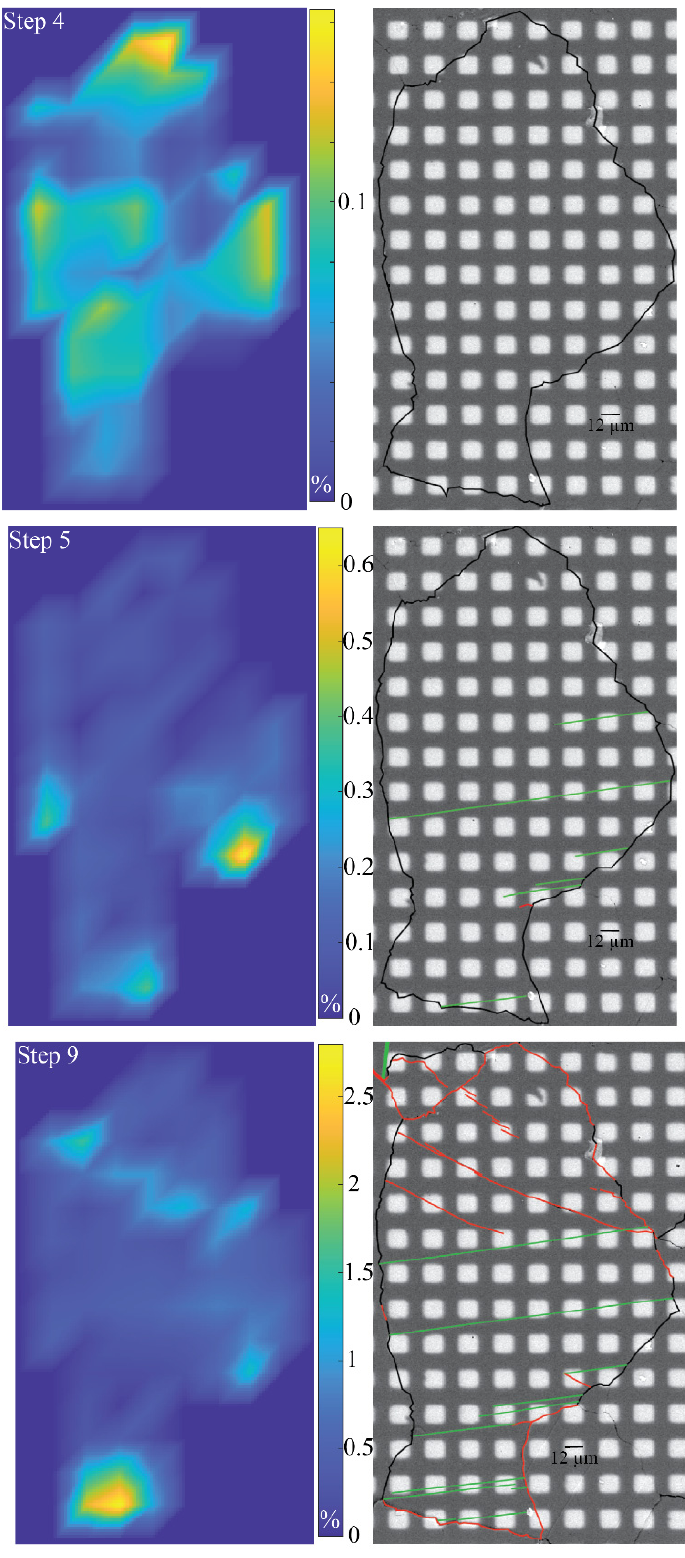
Figure 21. Equivalent Von Mises deformation map of crystal 15 at different steps of sample defor- mation. The black lines represent the grain boundaries. The green lines show the twinned planes. The red lines show the fracture